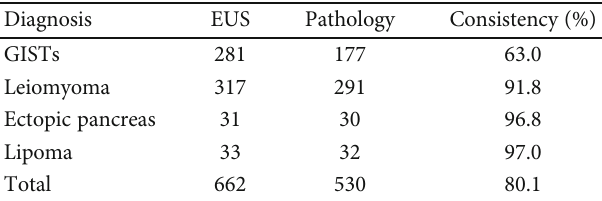
Table 4: Diagnostic consistency of EUS with pathology.